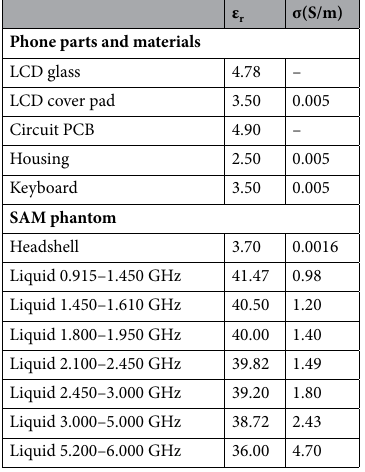
Table 2. Dielectric properties of the phone material and SAM